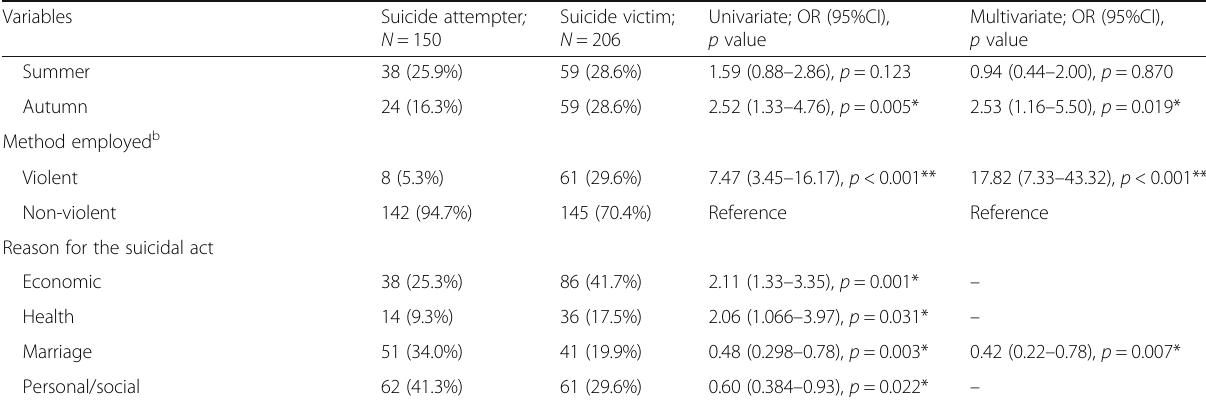
Table 1 Comparison of sociodemographic variables and suicide behavior characteristics (Continued)